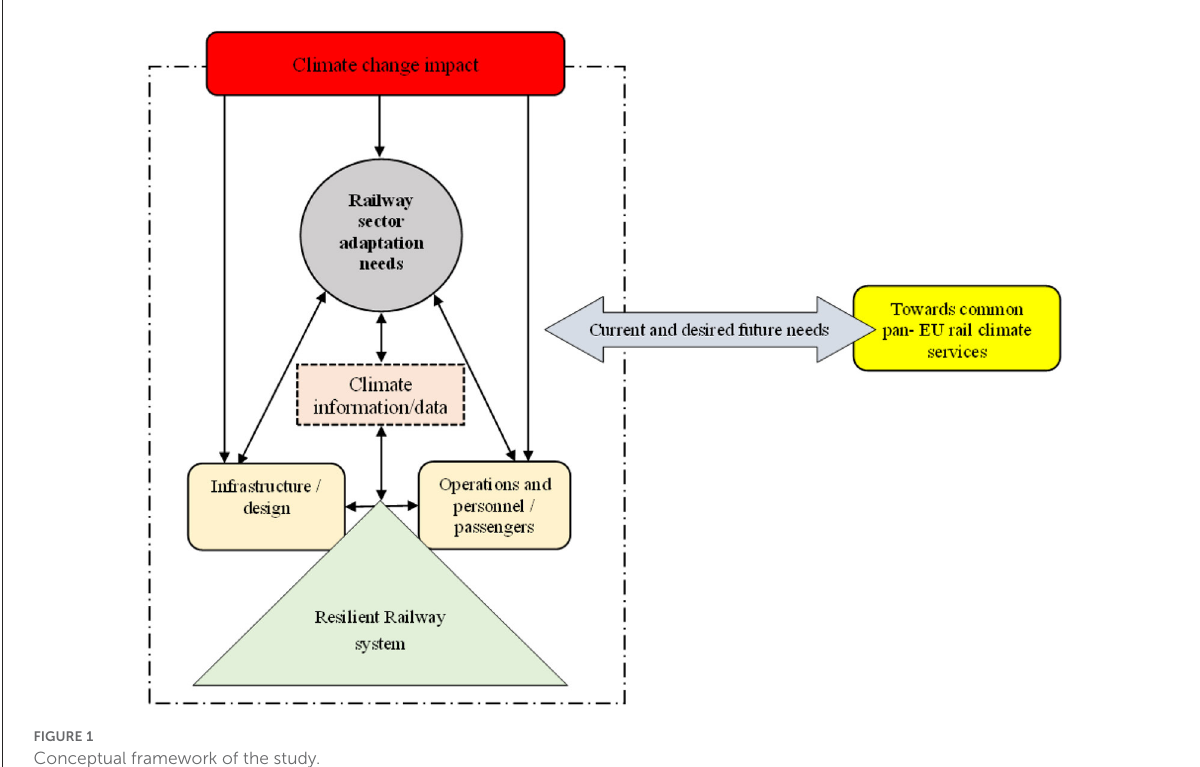
FIGURE1 Conceptual framework of the study.